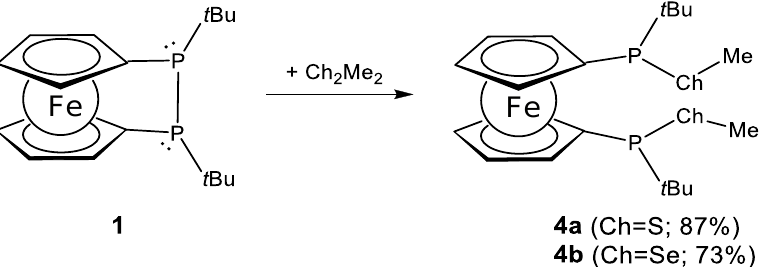
Figure 1. Molecular structure of 3a (top left), 3b (top right), and 3c (bottom) in solid state. Ellipsoids are shown at 30% probability, and all hydrogen atoms have been omitted for better overview. For 3a , two molecules were found within the unit cell from which one is depicted. Selected bond lengths and angles of 3a : S1-P1 2.1236(8) Å , S2-P2 2.1292(8) Å, ΣP1 =